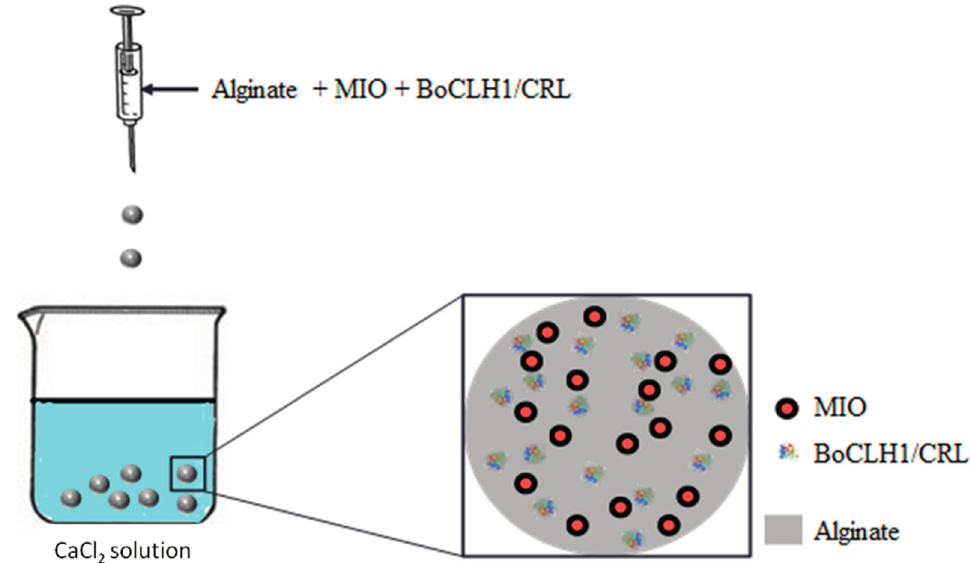
Figure 1. Schematic diagram showing the synthesis of enzyme encapsulated magnetic alginate composite beads. MIO is magnetic iron oxide (Fe 3 O 4 nanoparticles); BoCLH1 is Brassica oleracea chlorophyllase 1; CRL is Candida rugosa